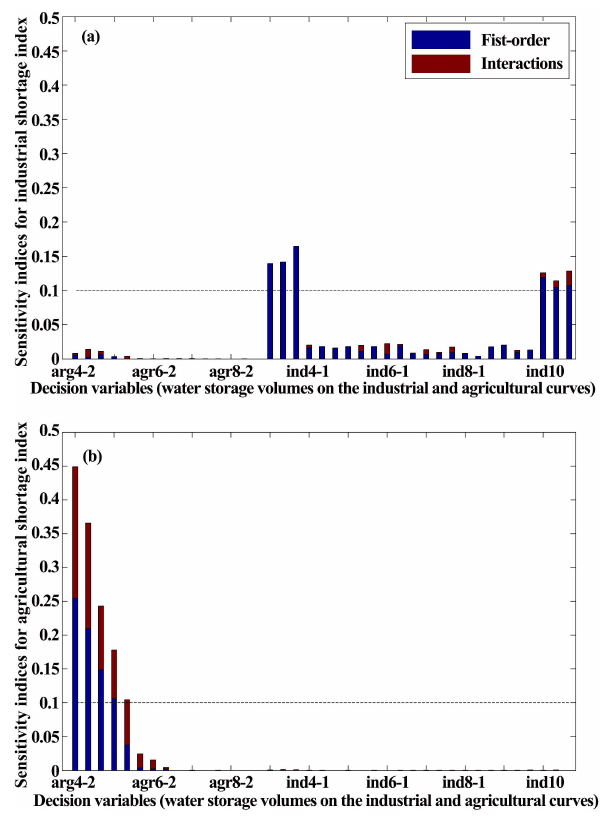
Figure 4. First-order and total-order indices for the Dahuofang ROS problem regarding (a) industrial shortage index and (b) agricultural shortage index. The x axis labels represent decision variables (water storage volumes on the industrial and agricultural